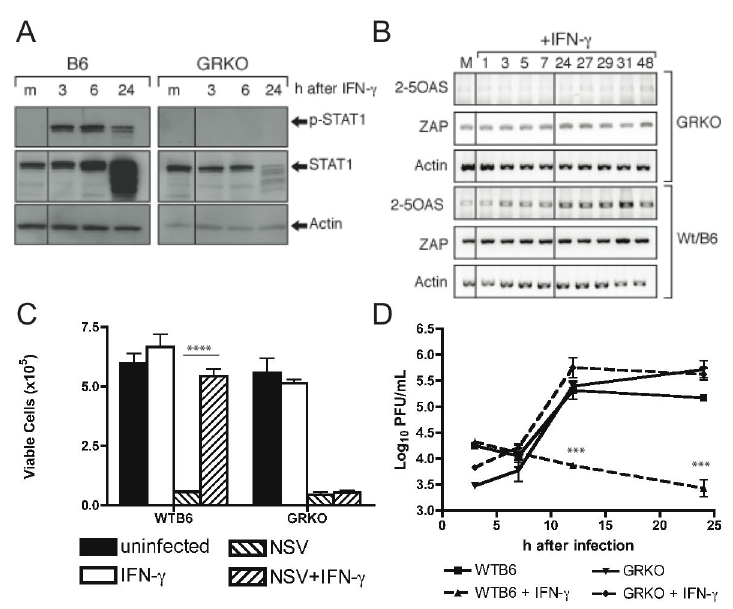
Figure 4. Effect of IFN-gamma on NSV infection of mouse embryo fibroblasts from GRKO and WTB6 mice. The responses of MEFs from WTB6 and GRKO mice to treatment with 100 U recombinant rat IFN-gamma were assessed over 24-48h. (A) Immunoblot to detect phosphorylation of STAT1 tyrosine 701 and changes in STAT1 protein levels. A representative of 3 experiments is shown. (B) RT-PCR to detect changes in transcription of antiviral genes 2-5 oligoadenylate synthase (OAS) and zinc finger antiviral protein (ZAP). Data shown are representative of 3 experiments. (C) Cell viability as determined by trypan blue exclusion 24h after infection with NSV (MOI = 5) in the presence and absence of IFN-gamma. Data are averaged from 2 experiments and plotted as mean +/- SEM. **** P < 0.0001; ANOVA (D) Effect of IFN-gamma on production of infectious virus by WTB6 (squares) and GRKO (triangles) MEFs after NSV infection with (dashed line) and without (solid line) IFN-gamma pretreatment. Data are from three experiments and plotted as mean +/- SEM. *** P < 0.001; ANOVA.